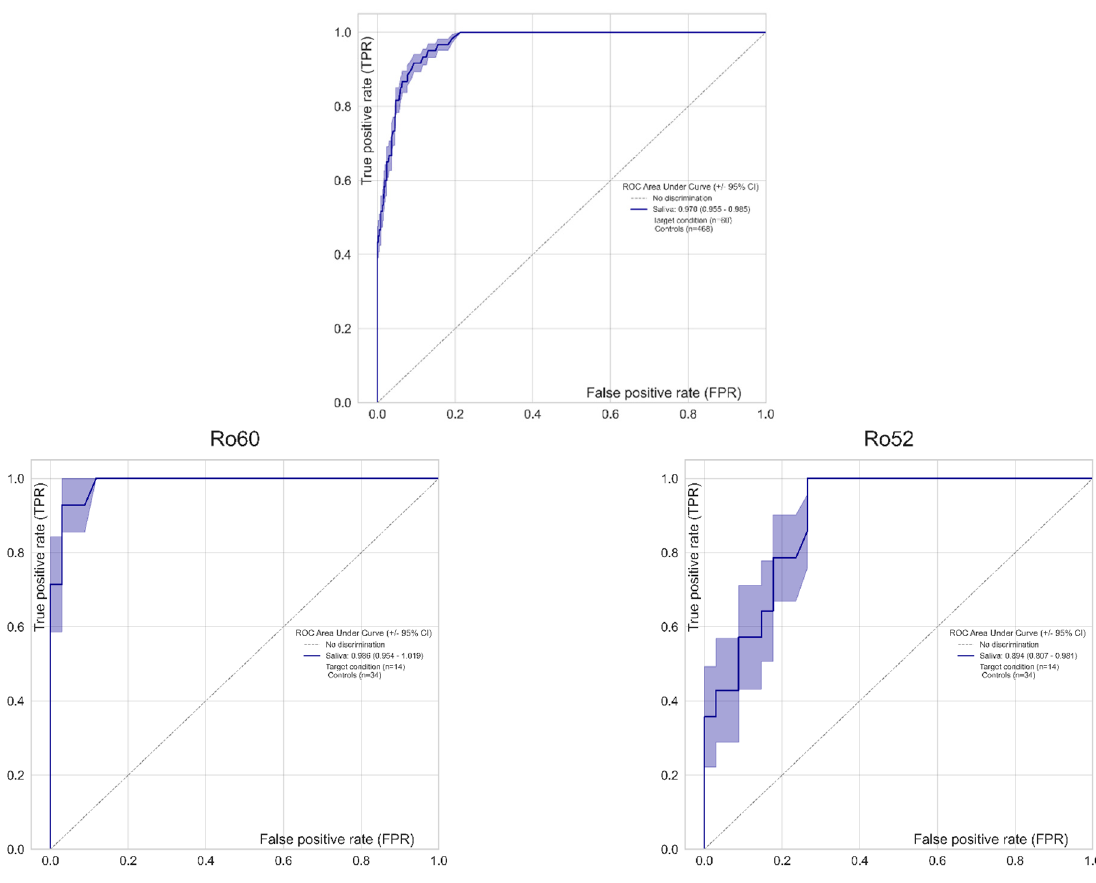
Figure 3. Receiver operating characteristic (ROC) analysis. The results obtained with saliva were used to generate a ROC curve using the serum results as a binary classifier. Results for all autoanti- bodies were analyzed pooled (all antibodies) or individually for RNP, Ro52, Ro60, and dsDNA. The results show a very high level of discrimination between serum positive and negative samples de- pending on the antibody titer defined using saliva samples. The area under the ROC curve was 0.97.